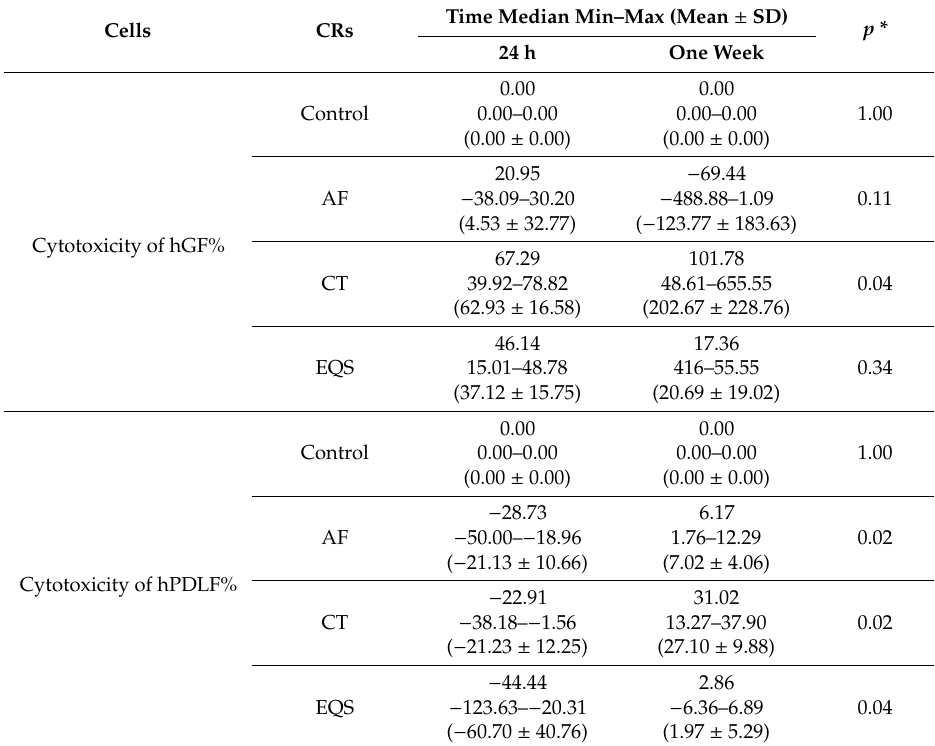
Table 3. Intragroup cytotoxicity e ff ect of CRs on hGF and hPDLF cell lines at 24 h and one week time